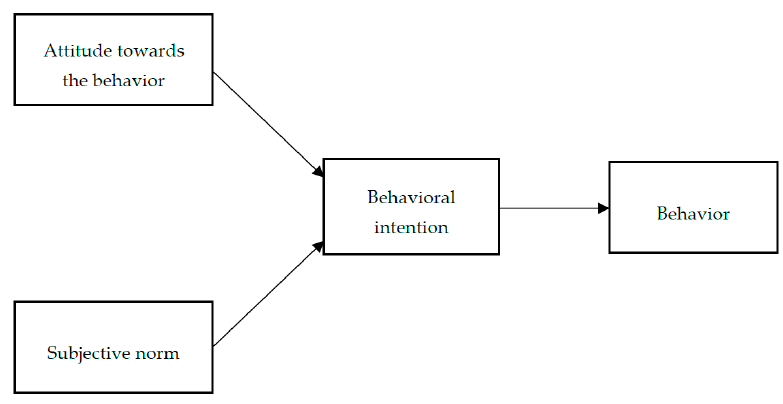
Figure 1. Theory of Reasoned Action (TRA). Source: Ajzen and Madden [23].